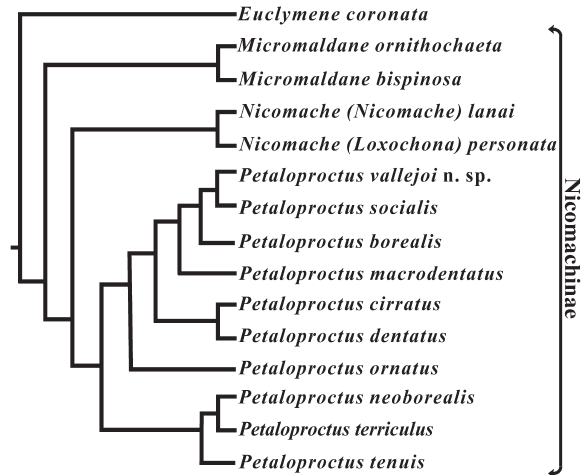
Fig . 2. – strict consensus of three most parsimonious phylogenetic trees with equal weighting (tree length = 37 steps, Ci = 0. 89; ri = 0.92).